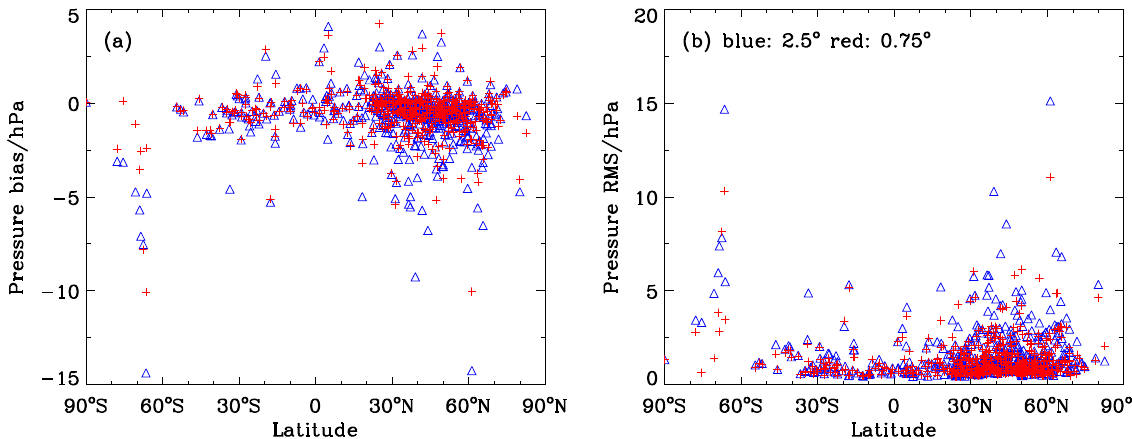
Figure 3. Distribution of station-wise bias ( a ) and RMS ( b ) values of pressures derived from ERA surface analysis data (blue triangle: 2.5° × 2.5°; red cross: 0.75° × 0.75°) with the Berg reduction method at 530 IGRA stations in 2015.